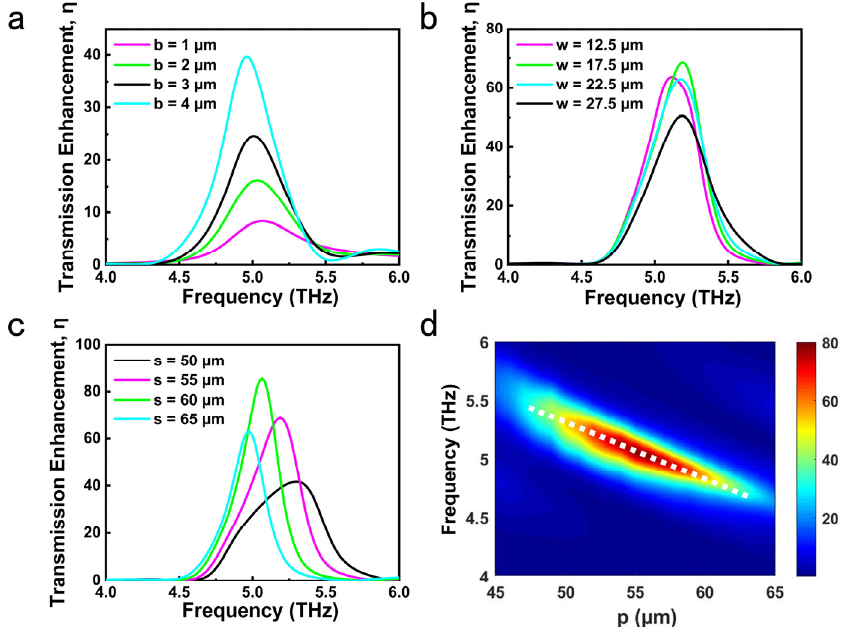
Figure 2. Variation of the transmission enhancement spectra as a function of structural parameters of grooves. ( a ) Effect of the groove depth on the transmission enhancement of the HIHB structure ( w = 30 µm, s = 55 µm, p = 60 µm, N = 5); ( b ) effect of the groove width on the transmission enhancement of the modified structure ( b = 4 µm, s = 55 µm, p = 60 µm, N = 5); ( c ) effect of the distance from the aperture to the first groove on the transmission enhancement of the modified structure ( b = 4 µm, w = 17.5 µm, p = 60 µm, N = 5); ( d ) the color map of transmission enhancement spectra for the HIHB structure ( b = 4 µm, w = 17.5 µm, s = 60 µm, N = 5) with different groove period p .